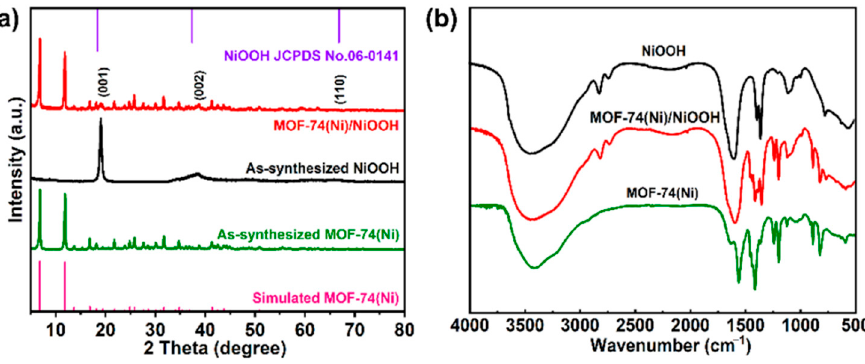
Figure 1. ( a ) PXRD patterns of the as-prepared NiOOH, MOF-74(Ni), and MOF-74(Ni)/NiOOH. ( b ) FT-IR patterns of as-prepared NiOOH, MOF-74(Ni), and MOF-74(Ni)/NiOOH samples. The corresponding morphological evolution of NiOOH and MOF-74(Ni)/NiOOH were characterized by field emission scanning electron microscopy (SEM). As shown in Figures 2a and S1a, the obtained NiOOH precursor had a hierarchical microsphere structure self-assembled from small NiOOH sheets. When reacting with a specific amount of DOBDC ligand, the as-prepared MOF-74 (Ni)/NiOOH (Figures 2b,c and S1b) showed aggregation from a large amount of nanorods. The spherical NiOOH was not observed due to its low content. Furthermore, a transmission electron microscopy (TEM) image further revealed the morphology of the nanorods for MOF-74(Ni)/NiOOH (Figure 2d). The selected electron diffraction (SAED) confirmed that MOF-74(Ni) particles had the nature of crystalline state (Figure 2e). High-resolution TEM (HRTEM) showed the lattice fringes of 0.211 nm, which might be ascribed to the (223) plane of MOF-74(Ni). The unique hierarchical structure originated from the intermediate status during the in situ semitransformation reaction of NiOOH. The NiOOH microballoons were destroyed, and MOF-74(Ni) was generated on the surface. This well-arranged hierarchical structure could provide rapid charge and mass transport of the electrolyte to the reaction sites of the catalyst surface, resulting in an improved electrocatalytic process.